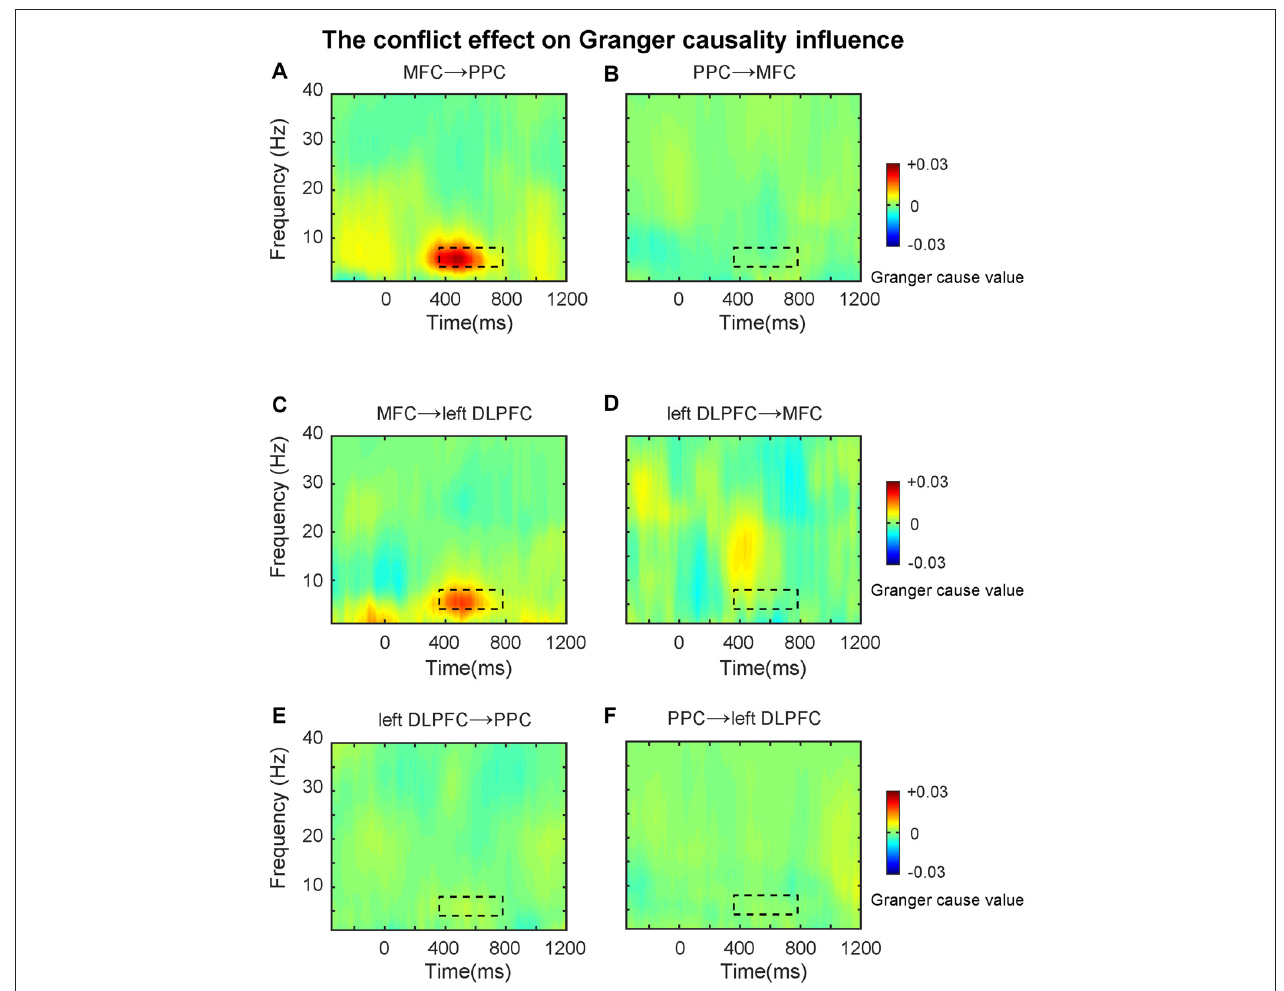
FIGURE 5 | The conflict effect on the Granger causality influence. TF plots for the conflict effect for (A) MFC → PPC; (B) PPC → MFC; (C) MFC → left DLPFC; (D) left DLPFC → MFC; (E) left DLPFC → PPC; (F) PPC → left DLPFC directed synchrony. The black dotted line denotes the time frequency window (4–8 Hz, 360–780 ms, based on the results from connectivity analysis), and data within this area were averaged and extracted to perform the ANOVAs. The Granger causality analysis primarily revealed the top-down directed influence involved in conflict control during subliminal affective priming.